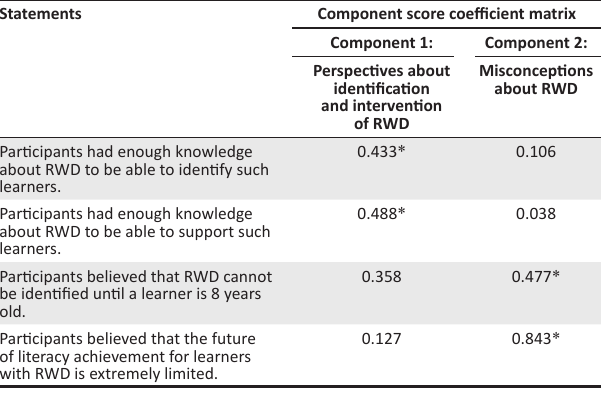
TABLE 6: Component score coefficient matrix for participants’ perspectives about identification and intervention of reading and writing